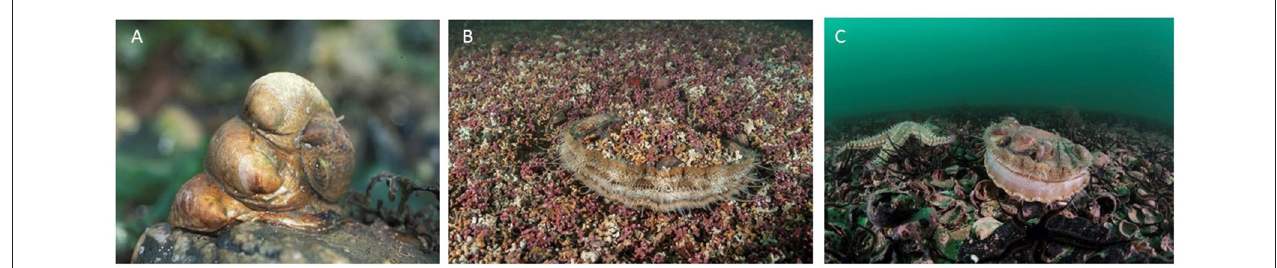
FIGURE 1 | Images of Crepidula fornicata (A) , of Pecten maximus, the Great Scallop (B) and of competition for space between those two benthic suspension feeders (C) .